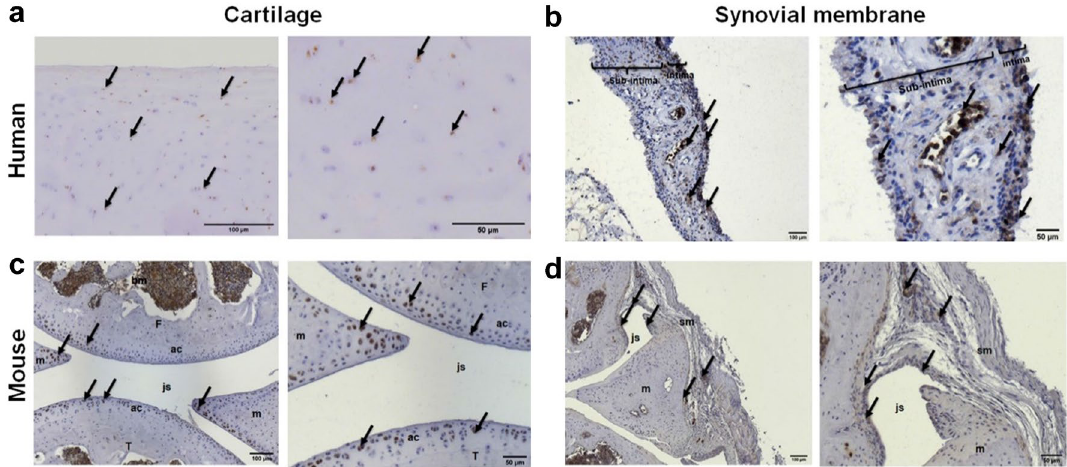
Figure 1. Expression of GLP-1 receptor in OA human and non-OA mouse knee joint. ( a ) Immunohistochemical staining of human OA knee cartilage sections was performed to determine the presence of GLP-1R (Mankin score: 3/14, scale bar = 100 µm or 50 µm). ( b ) Immunohistochemical staining of human OA synovial membrane sections was performed to determine the presence of GLP-1R ( si: subintima, i: intima, v: blood vessel, scale bar = 100 µm or 50 µm). ( c ) Immunohistochemical staining of non-OA mice knee joint sagittal sections to determine the presence of GLP-1R ( ac: articular cartilage, m: meniscus, js: joint space, T: tibia, F: femur, bm: bone marrow, scale bar = 100 µm or 50 µm). ( d ) Immunohistochemical staining of non-OA mice synovial membrane sagittal sections to determine the presence of GLP-1R ( sm: synovial membrane, js: joint section, m: meniscus, scale bar = 100 µm or 50 µm). Control experiment was performed without primary antibody incubation. Arrows indicate example of cells positive for GLP-1R staining.